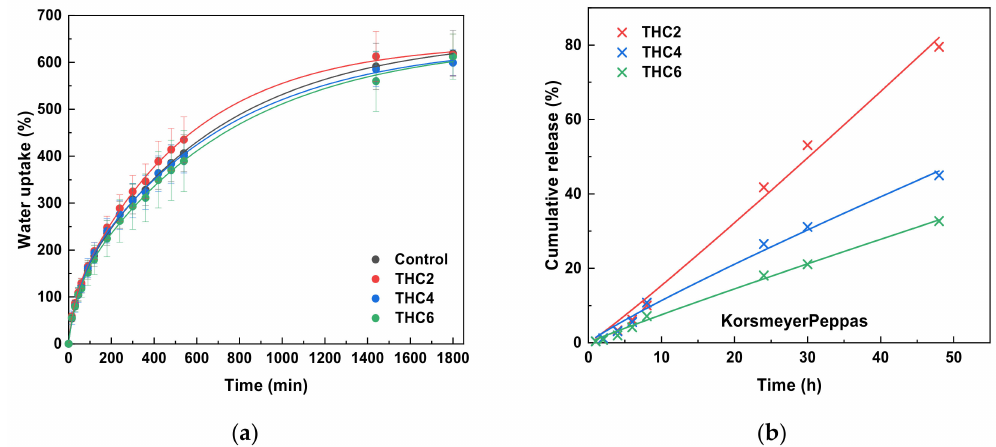
Figure 9. ( a ) Water uptake and ( b ) THC release from THC–collagen scaffolds (data fitted to Korsmeyer–Peppas model).